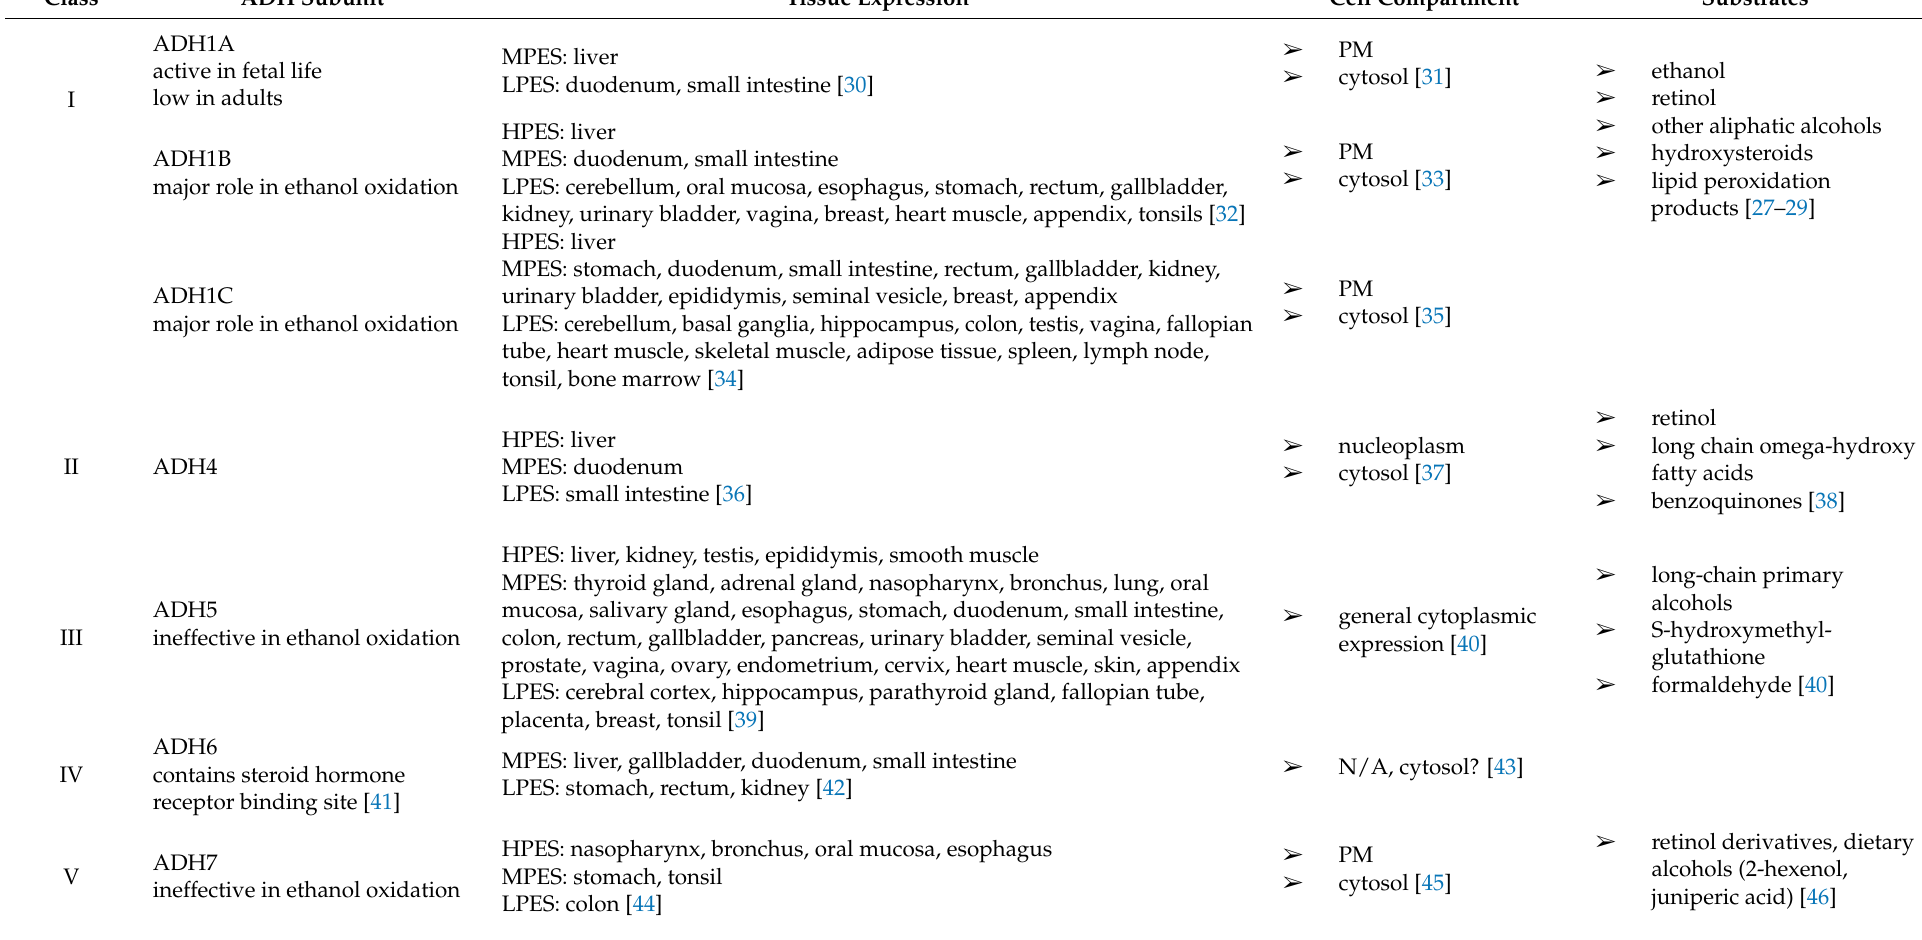
Table 1. Classes of ADH and tissue/cell ADH expression based on information mainly from Human Protein